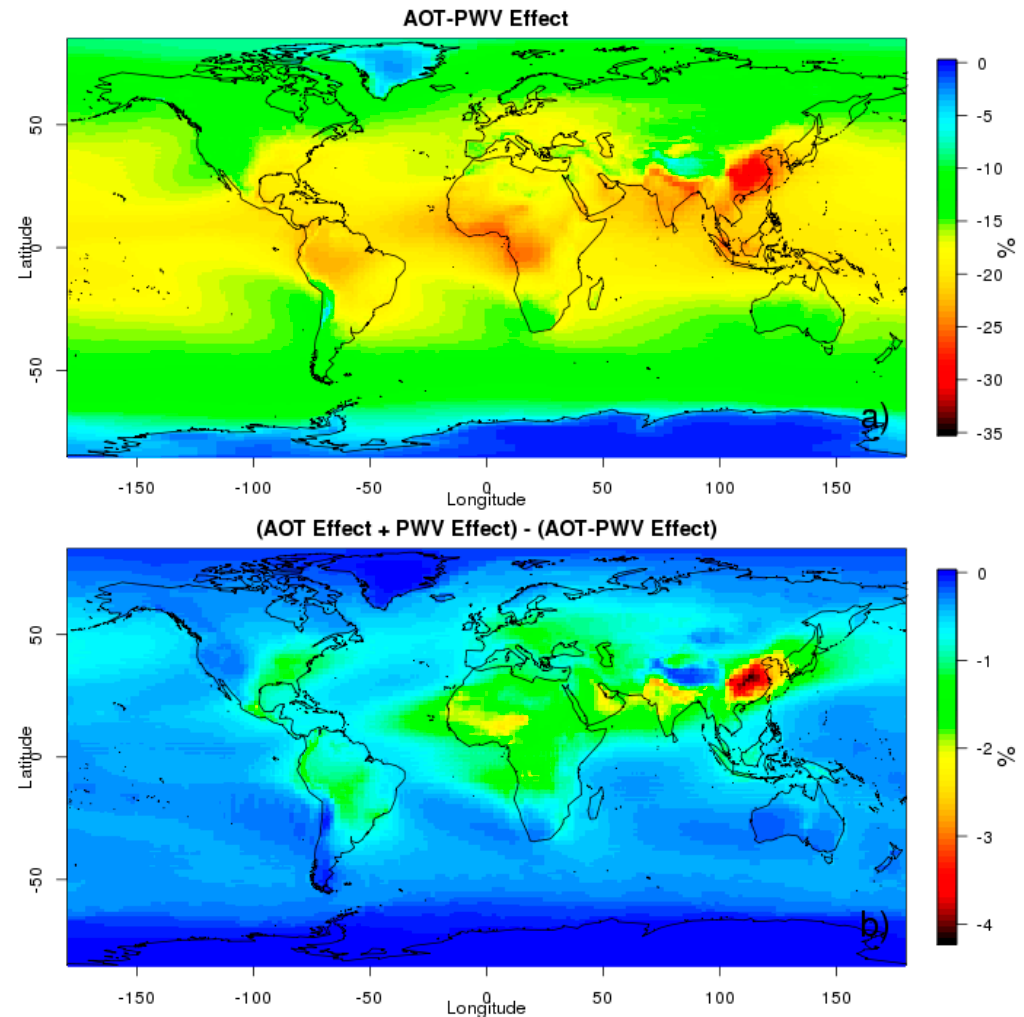
Figure 8. Global spatial distribution of averaged values of ( a ) AOT-PWV effect and ( b ) differences between the sum of the individual effects (AOT effect + PWV effect) and AOT-PWV effect during the period 2000–2019. AOT-PWV effect is quantified by Equation (1) and refers to the effects on downwelling SW irradiance reaching the Earth’s surface under different values of AOT and